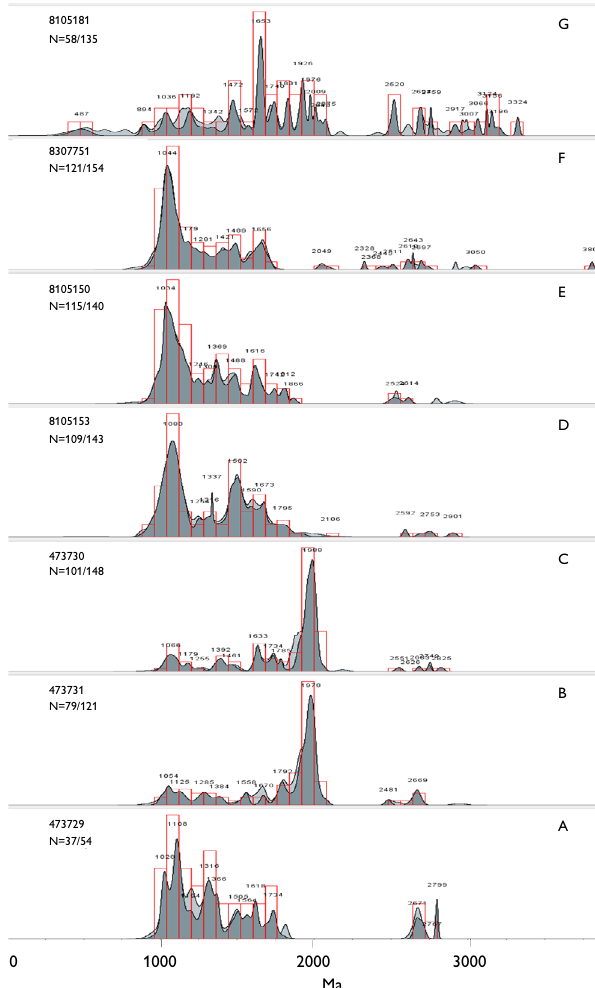
Fig. 3. Detrital zircon age distribution histograms of the seven samples ( A–G ) selected in Fig. 2. (Rehnström et al. 2010). The histograms are gen- erated according to Thomsen et al .